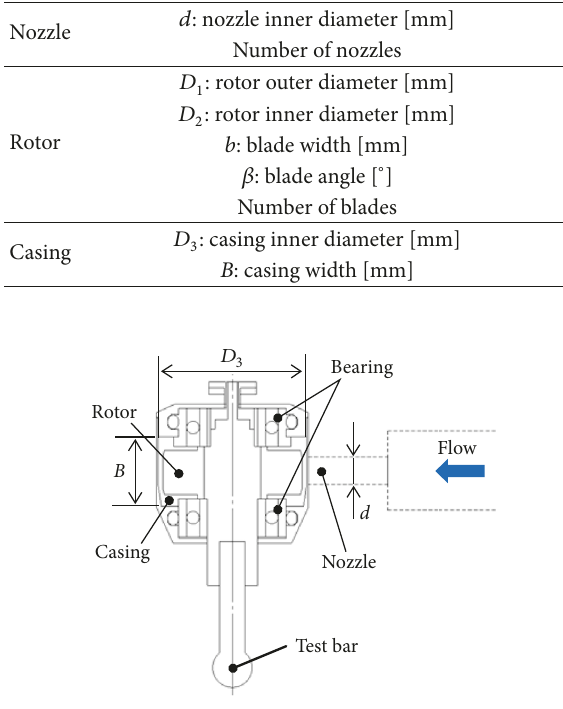
Figure 2: Schematic of turbine section.